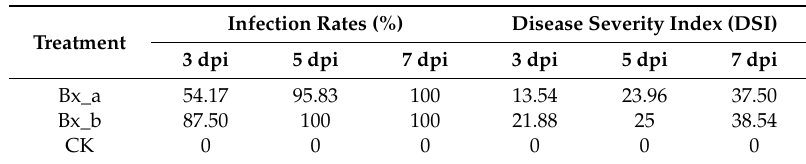
Figure 1. Disease phenotype of pine seedlings inoculated with aseptic B. xylophilus (Bx_a), B. xylophilus with S. maltophilia (Bx_b), or S. maltophilia alone (CK), at 0, 3, 5, and 7 days post inoculation (dpi), respectively. Table 1. The degree of pine wilt disease after P. massoniana seedlings were inoculated with aseptic B. xylophilus (Bx_a), B. xylophilus with S. maltophilia (Bx_b), or S. maltophilia alone (CK), at 3, 5, and 7 days post inoculation (dpi), respectively.